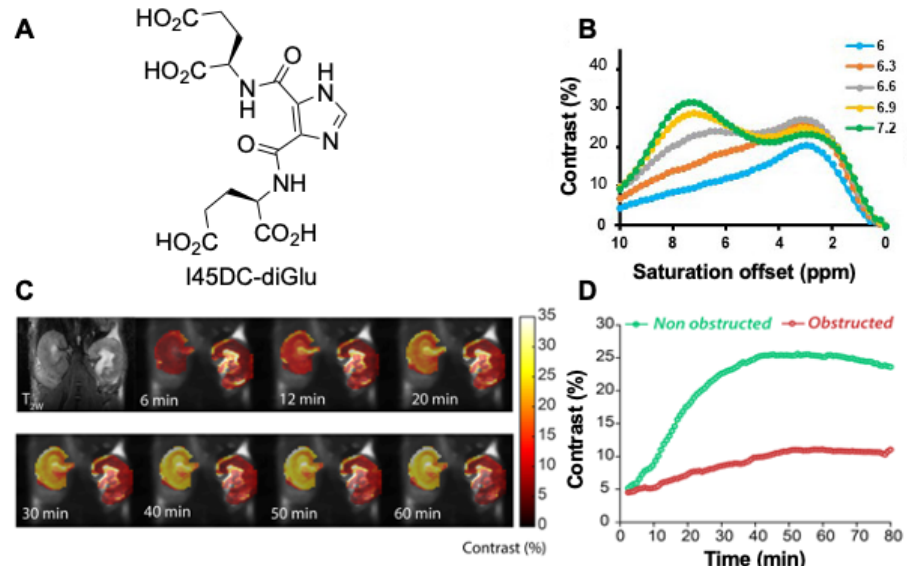
Figure 7. Imaging unilateral urinary obstruction in mice using Imidazole CEST MRI agent; ( A ) Imidazole-4,5-dicarboxamide-di Glutamate (I45DC-diGlu) structure; ( B ) Experimental MTR asym spectra for I45DC-diGlu as a function of pH t sat = 3 s, ω 1 = 6.0 μ T, 37 °C; ( C ) in vivo kidney images; Experimental conditions: t sat = 3 s, ω 1 = 6.0 μ T. Dynamic CEST images were acquired using the same 2 offset CEST protocol described in Figure 6 for Iopamidol. Two CEST images at offsets 4.3 and 7.5 ppm were acquired repeatedly for a total time of 76 min and 10 set of M0 images at offset 40 ppm were collected. Time interval between two dynamic CEST images was 44 s; ( D ) Average parenchymal contrast for obstructed and non-obstructed kidney.